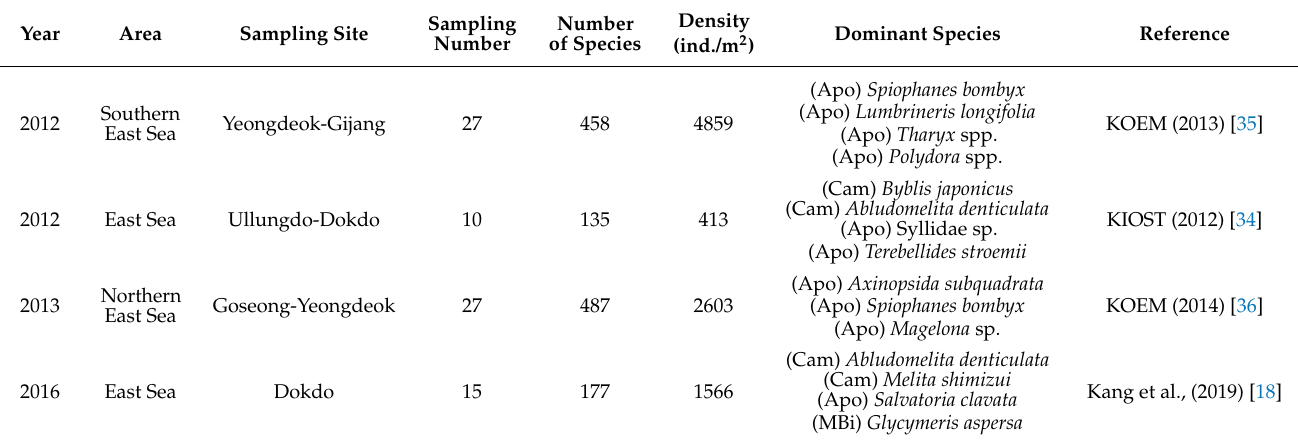
Table 6. Macrobenthos species number and density (ind./m 2 ) and dominant species in previous studies of the East